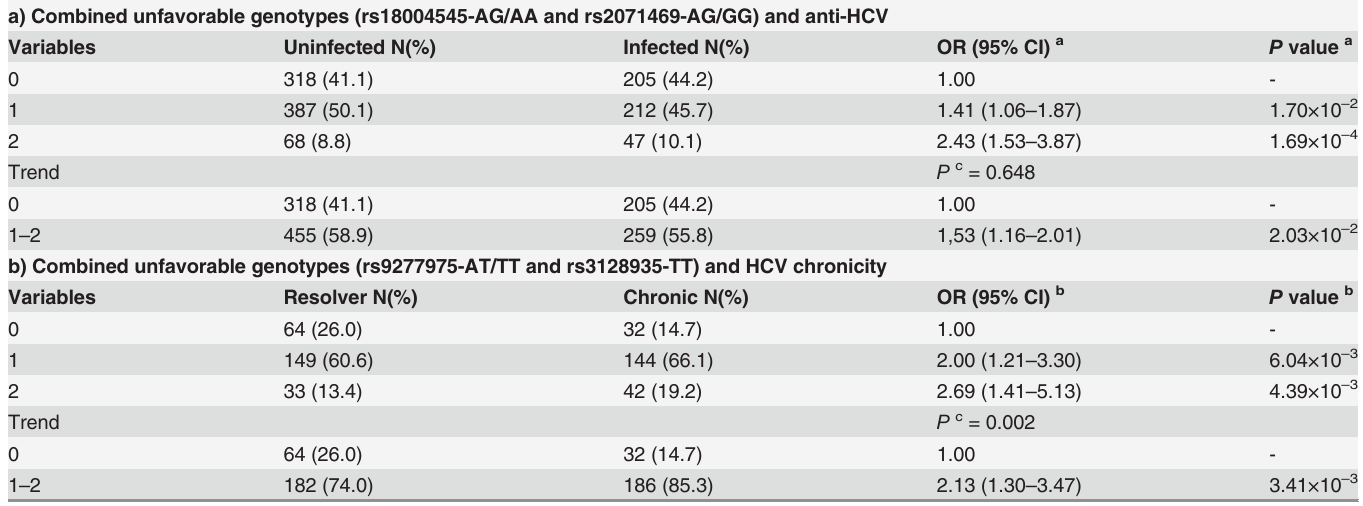
Table 4. Cumulative effects of selected SNPs on HCV infection outcomes.